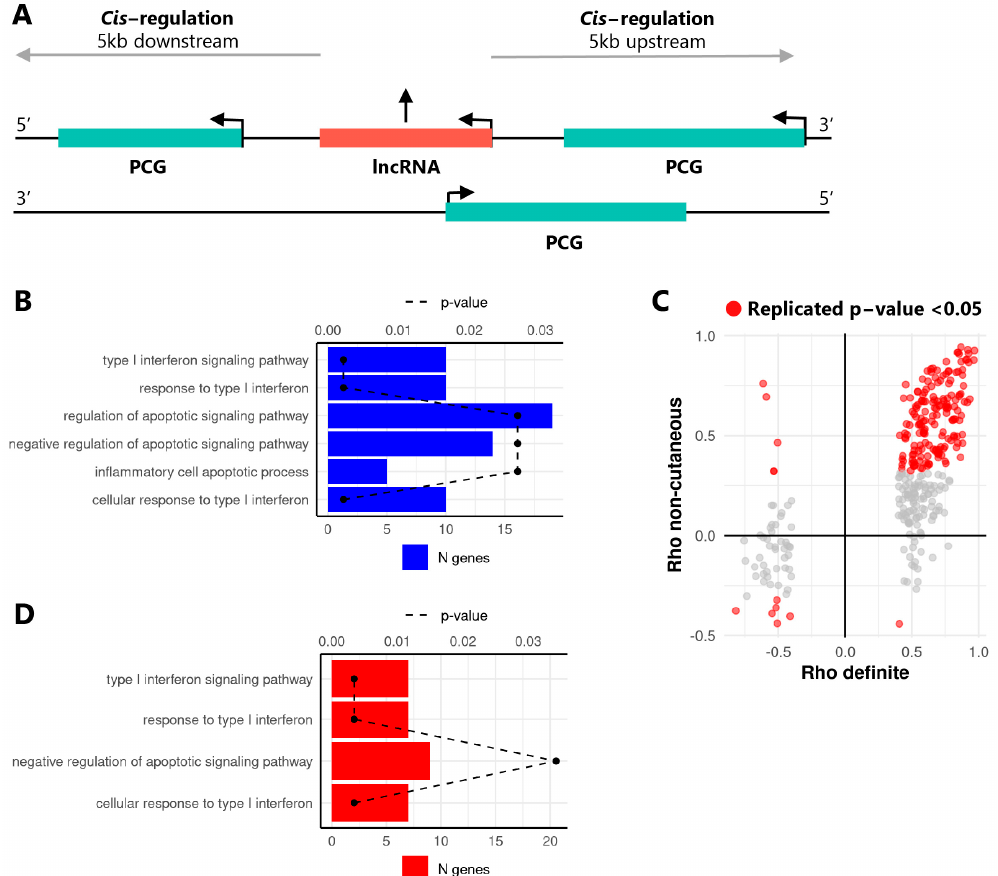
Figure 1. Differentially expressed lncRNAs are correlated with cis localized protein coding genes relevant for SSc patho- genesis. ( A ) Schematic overview of the cis correlation approach to identify neighboring long non-coding RNAs (lncRNA, red) and protein coding genes (PCGs, green). Arrows indicate the direction of transcription. ( B ) GO-term enrichment analysis results of PCGs identified in the cis correlation analysis in the Definite SSc cohort. GO terms for significantly enriched biological processes are given on the y -axis. Bars depict the number of genes identified within the enriched pathway (N genes, bottom x -axis), dashed line indicates B&H corrected p -value of the enrichment ( p -value, top x -axis). ( C ) Correlation coefficients (Spearman’s Rho) between lncRNAs and PCGs in the Definite ( x -axis) and Non-cutaneous ( y -axis) cohorts. Each dot represents a lncRNA-PCG pair. Grey dots represent pairs significantly correlated in the Definite cohort only, while red dots represent pairs significantly correlated in both cohorts (Spearman’s rho >0.4 or < − 0.4, and p -value ≤ 0.05). ( D ) GO-term enrichment analysis results of protein coding genes from the in cis correlation analysis rep- licated the Non-cutaneous cohort.